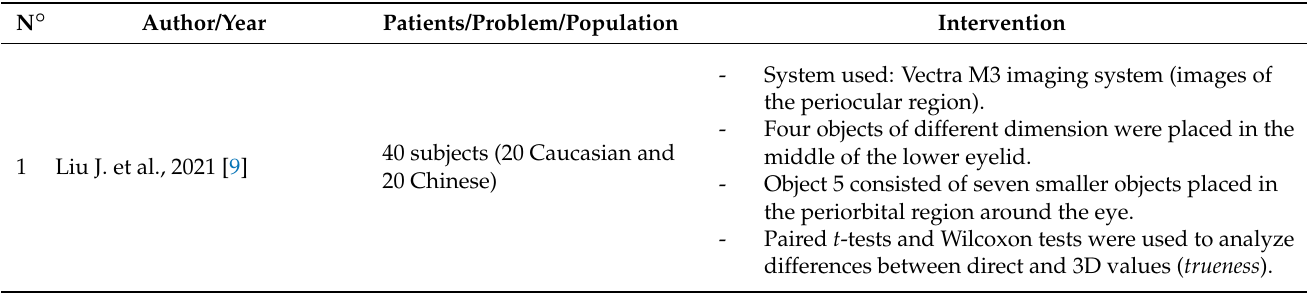
Table 2. Articles validating Canfield’s Vectra static devices. (Original definitions are maintained. Results are re-labeled in italic with definitions according to